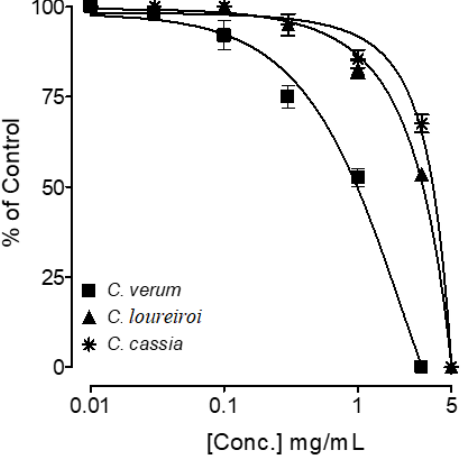
Figure 3. Concentration–response curves showing the comparison of the essential oil C. verum , C. bureiroi and C. cassia for the bronchodilator effect against carbachol (CCh; 1 µ M)-induced contractions in guinea pig tracheal strips preparations. Results are expressed as mean ± SEM, n = 4. Among the pure compounds tested, complete inhibition of CCh-1 uM mediated contractions was observed using 1 with resultant EC 50 values of 0.40 mg/mL (0.29–0.54; n = 4) while non-significant ( p > 0.05) inhibition was observed with compound 2 with maximum relaxation of 5% whereas compound 4 was found inactive at the highest tested concentration of 1 mg/mL (Figure 4).